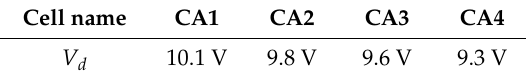
Table 2. Driving voltage test result with different electrode structures.